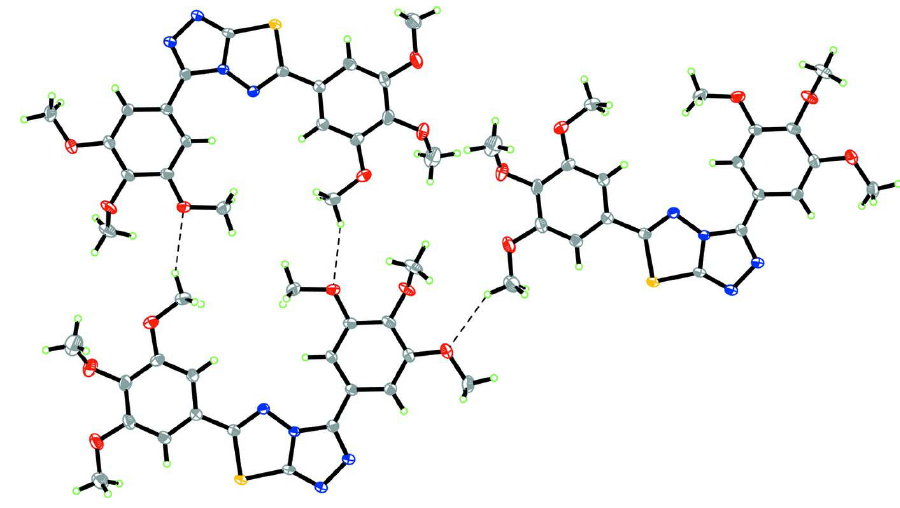
A partial packing diagram of the title compound. Hydrogen bonds are shown as dashed